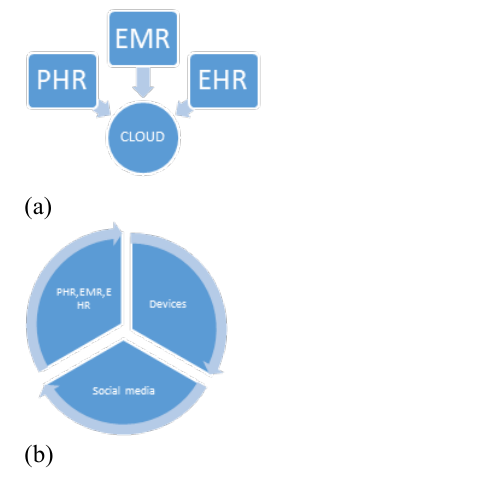
Figure 1. Evolution of intersecting trends (a) between cloud computing and the EMRs, EHRs and PHRs. (b) between health records, devices and social media